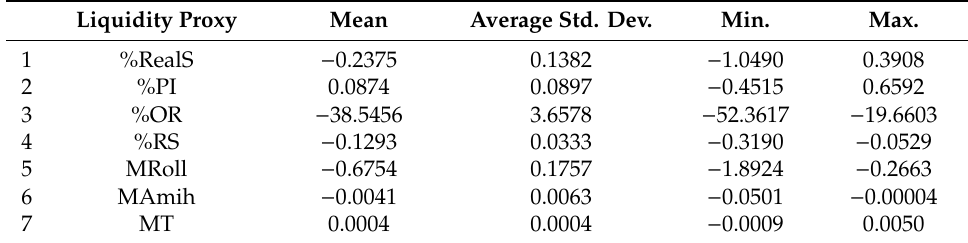
Table 3. Basic descriptive statistics for cross-section of liquidity proxies within the whole sample period January 2005–December 2016 (3005 trading days for each variable). Liquidity